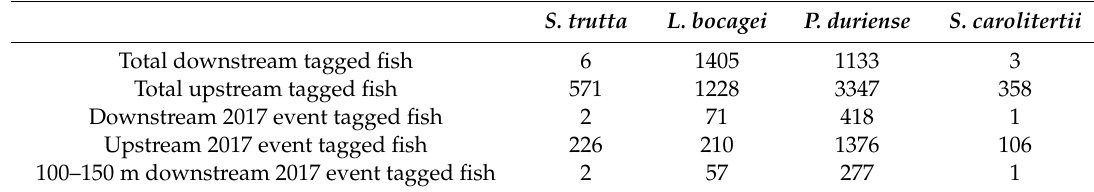
Table 3. Number of fishes tagged at the upper Tormes basin until December 2017. Downstream and upstream refers to the dam